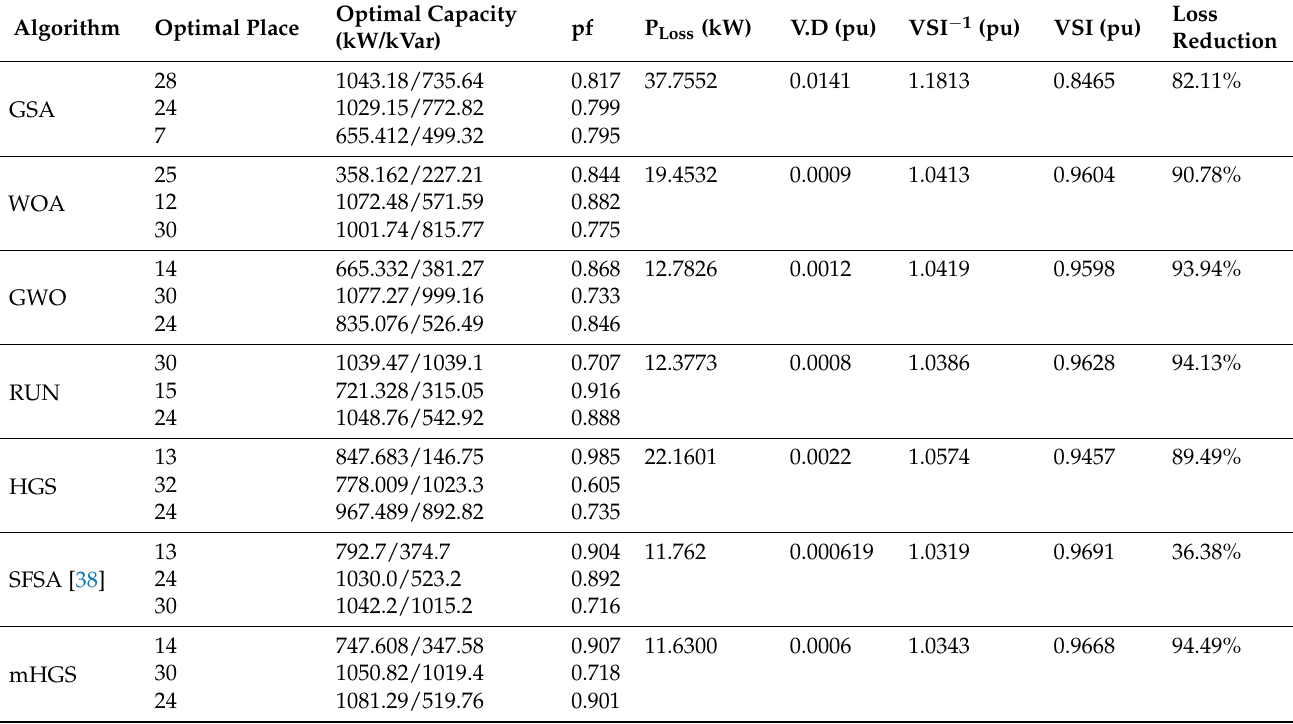
Figure 4. IEEE 33-bus network layout. Table 5. The optimal results obtained via different optimizers applied to the IEEE